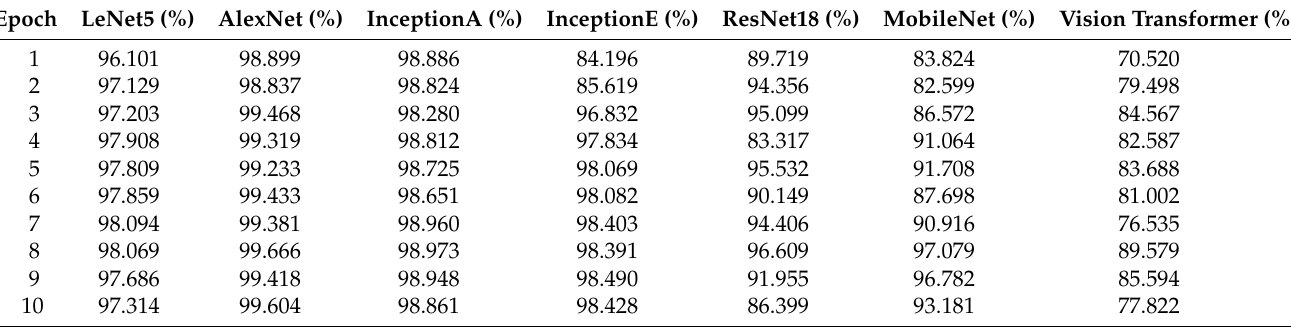
Table 8. Comparison of the accuracy of identifying surface cracks of soil and rock masses in each